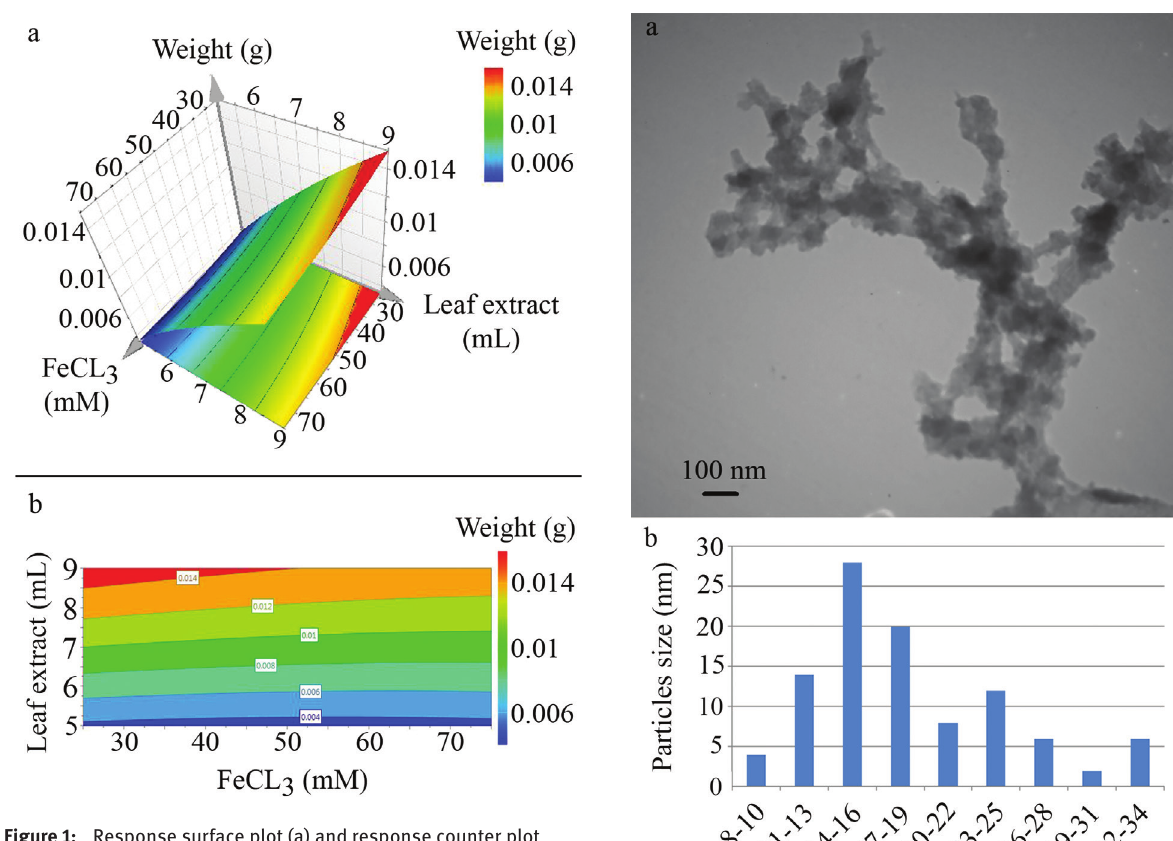
Figure 1: Response surface plot (a) and response counter plot (b) for the fabrication of INPs showing the effects of iron precursor concentration and amount of leaf extract in a green synthesis reaction, all reactions were done in 10 mL final